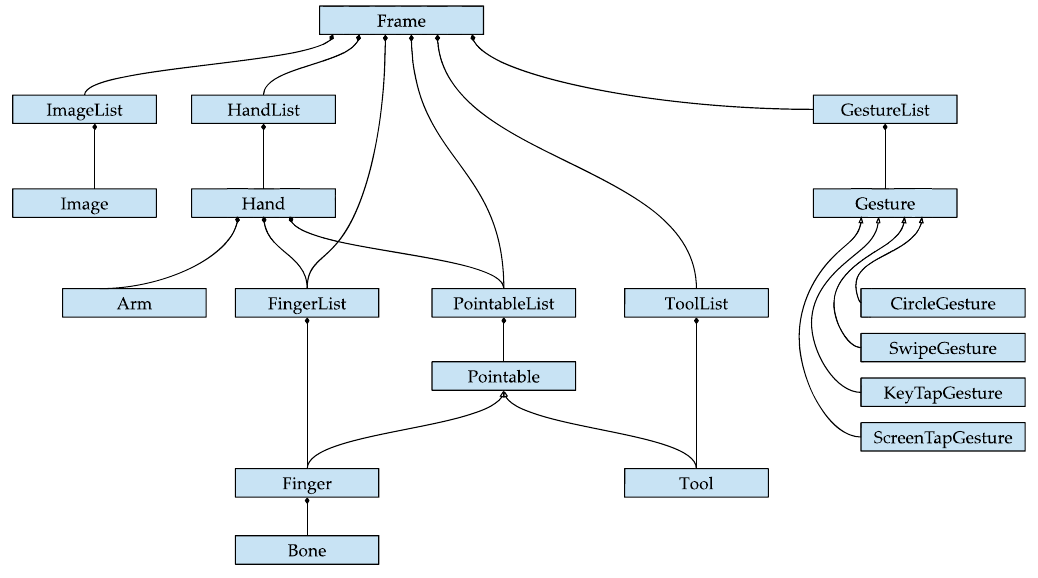
Figure 11. Frame Object of Leap Motion Source.